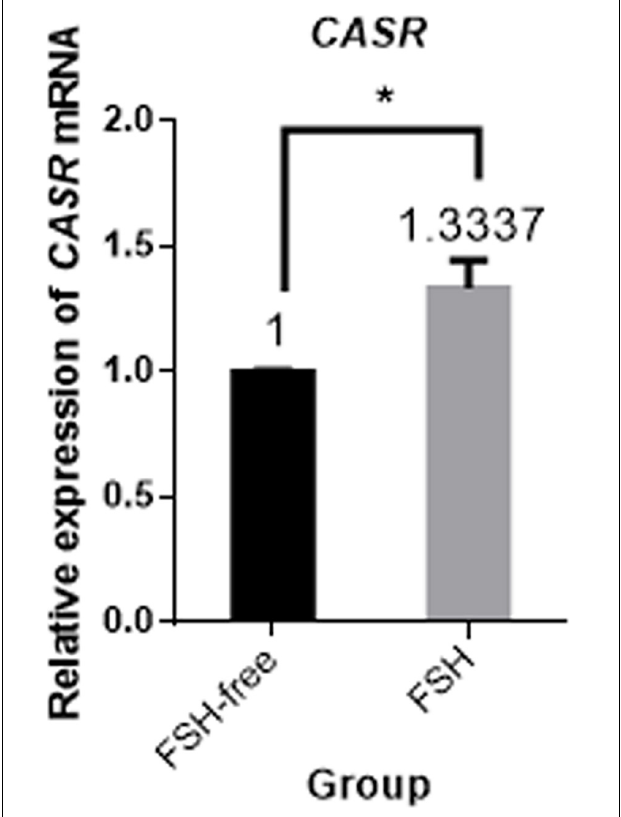
FIGURE 2 | Relative expression of CASR mRNA in porcine cumulus cells from COCs matured in the presence or absence of FSH for 24 h by qRT-PCR. Data are presented as means ± SEM (* p < 0.05) from three independent experiments. (*) indicates significance between groups. Significance was determined by independent t -test. CASR, Calcium-Sensing Receptor.